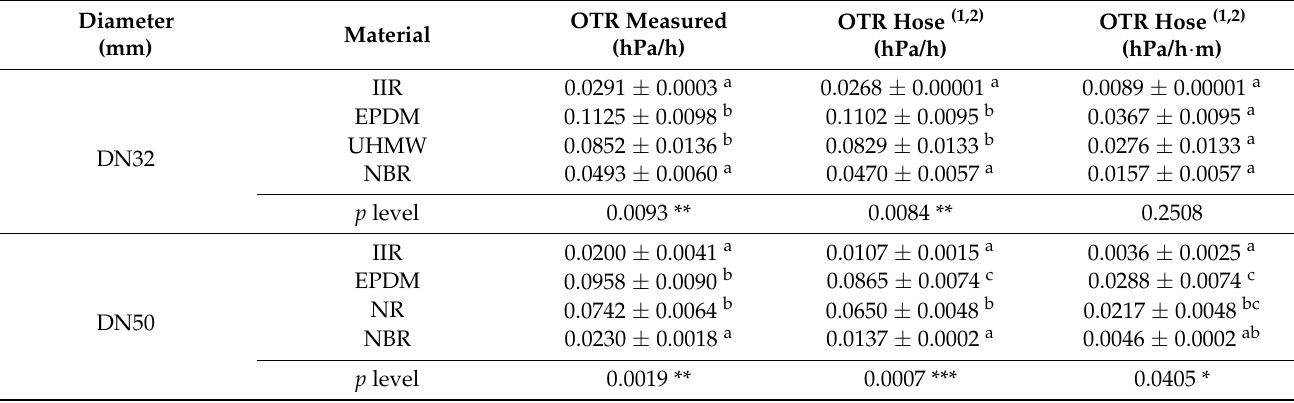
Table 3. Oxygen transmission rate (hPa/h) achieved in hoses of different materials in the two tested diameters ( n = 3). Diameter